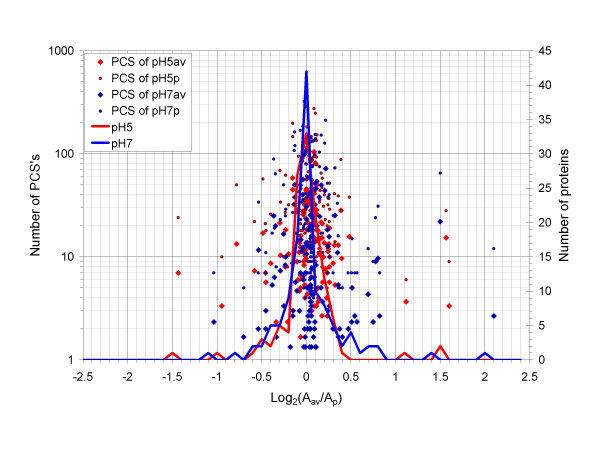
Random fluctuation. The number of quantified PCS's of a protein is plotted against the log ratio of the average relative abundance of its biological triplicates (Aav, representing either ApH5av or ApH7av) over the relative abundance of its in silico pooled replicate (Ap, representing either ApH5p or ApH7p) for the pH5 and pH7 samples respectively. The red diamonds and the small red dots represent the pH5 sample. The blue diamonds and the small blue dots represent the pH7 sample. The diamond symbols represent the average number of PCS's of a protein of the biological triplicates. The small dots represent the number of total PCS's of a protein in the in silico pooled replicates. The histograms based on the number of quantified proteins are also plotted, with the red trace representing the pH5 sample and the blue trace representing the pH7 sample.